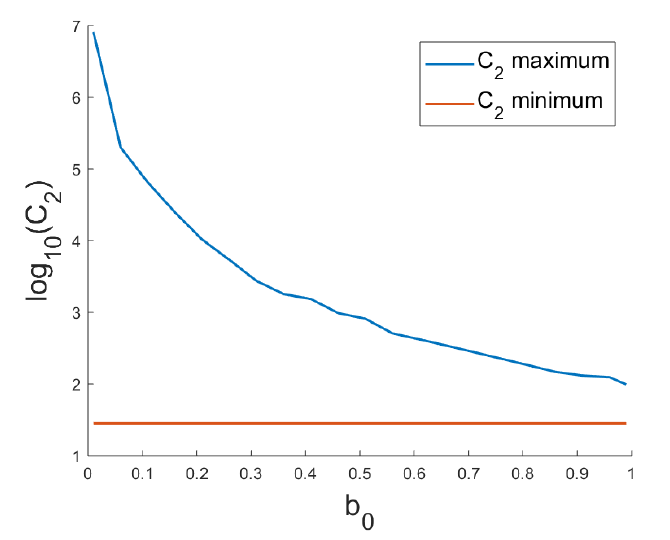
Figure 2. C 2 ( h , q ) for b > b 0 when h = 10 − 4